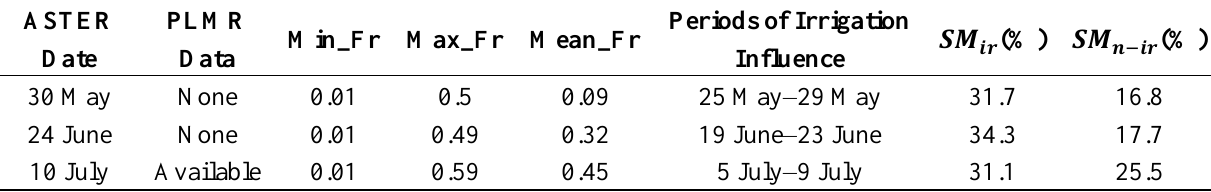
Figure 5. SM spatial trends modeled from the irrigation statistics and WSN data with 90m spatial resolution. The white areas in each map represent masked areas that contain buildings. Table 2. Summary of the ASTER, PLMR and irrigation